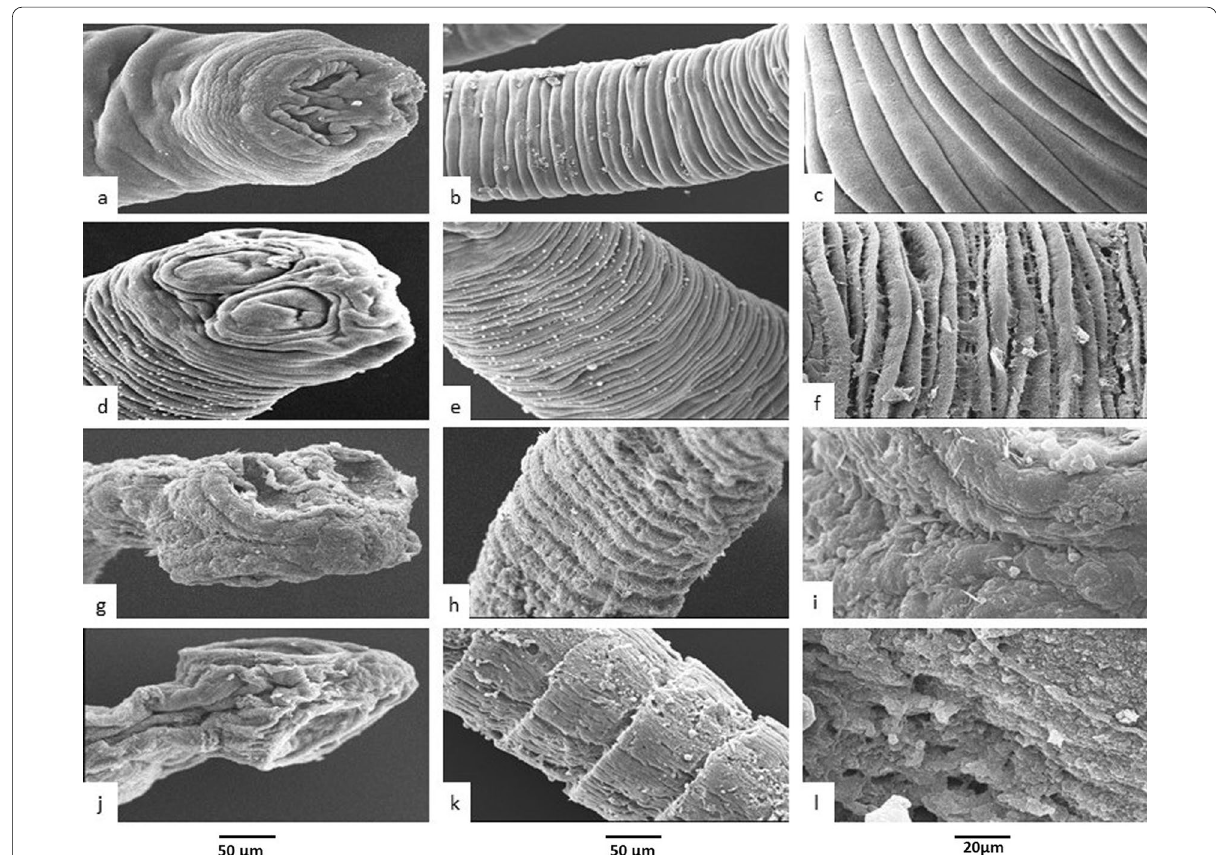
Fig. 1 Scanning electron micrographs of adult H. diminuta . a , b , c Control worms, showing scolex with normal suckers and intact tegument; d , e , f Worms exposed to PZQ (1 mg/ml), showing distorted suckers, contracted tegumental architecture, but normal microtriches; g , h , i Worms exposed to C. bonducella extract (30 mg/ml), showing shrunken suckers, eroded microtriches and distorted tegument; j , k , l Worms exposed to C. joufra extract (30 mg/ml), showing shriveled scolex, shrunken suckers, and irrevocable destruction over the tegumental